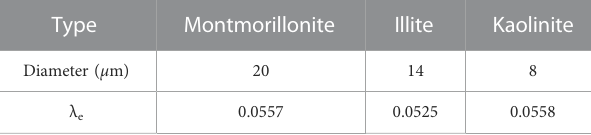
TABLE 3 λ e of mineral particles with different diameters.